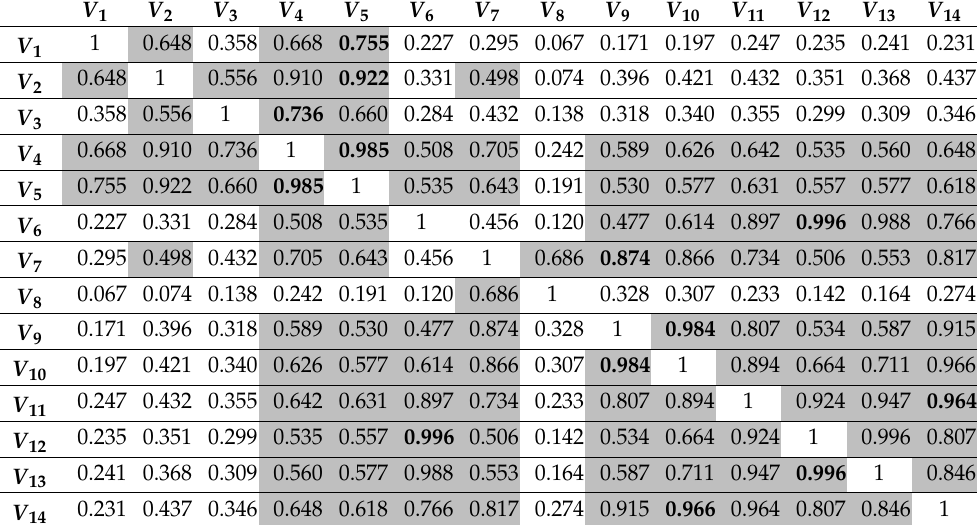
Table 1. Spearman’s rank correlation coefficient (SRCC) for different pairs of root-mean-square values of nodal voltages (RMS_NVs) in the test system.